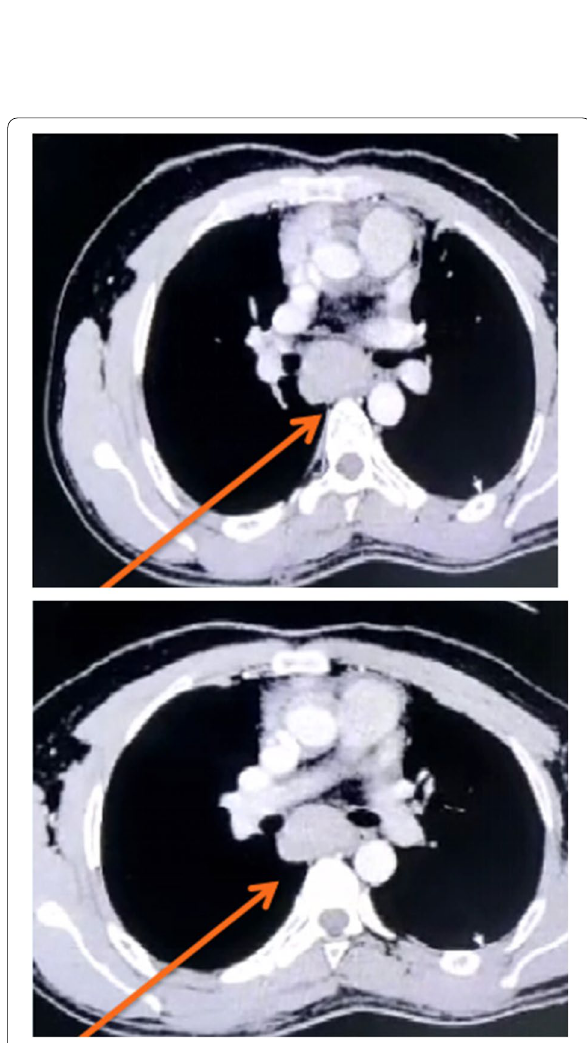
Fig. 2 HRCT thorax showing subcarinal lymphadenopathy